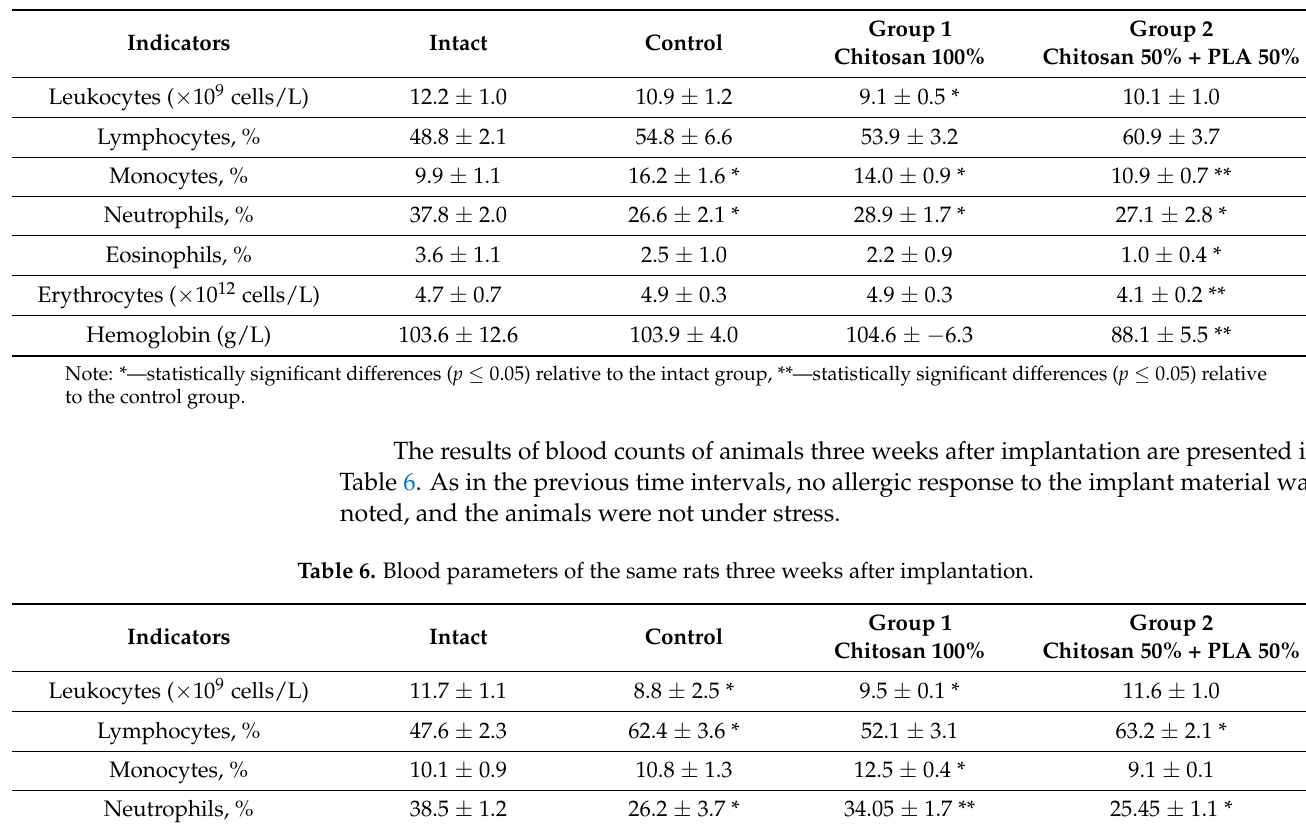
Table 5. Blood parameters of rats one week after implantation.